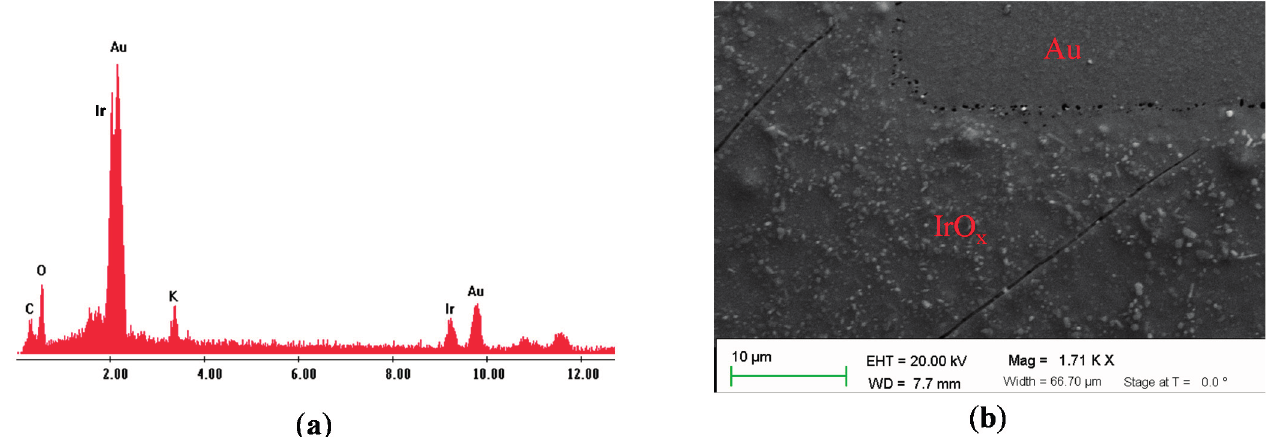
Figure 3. ( a ) Energy dispersive spectroscopy (EDS) shows visible peaks of Ir, Au, C, O, and K; ( b ) Scanning electron microscopic image of the surface on the microelectrode as indicated with the black circle in Figure